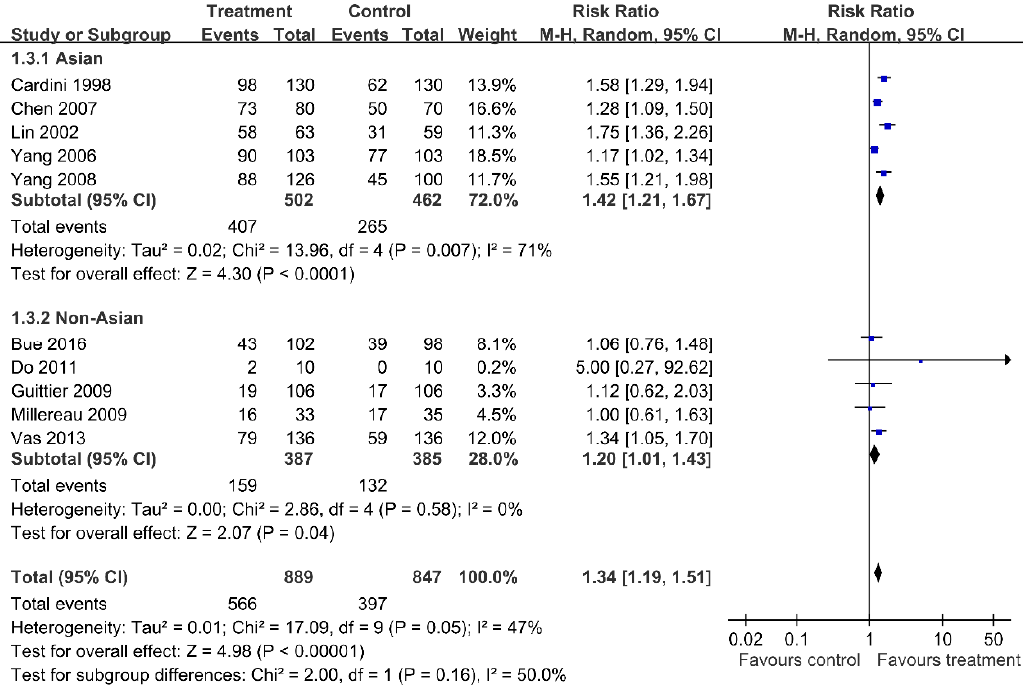
Figure 6. Subgroup analysis: Moxibustion versus Control; Outcome: Cephalic presentation.